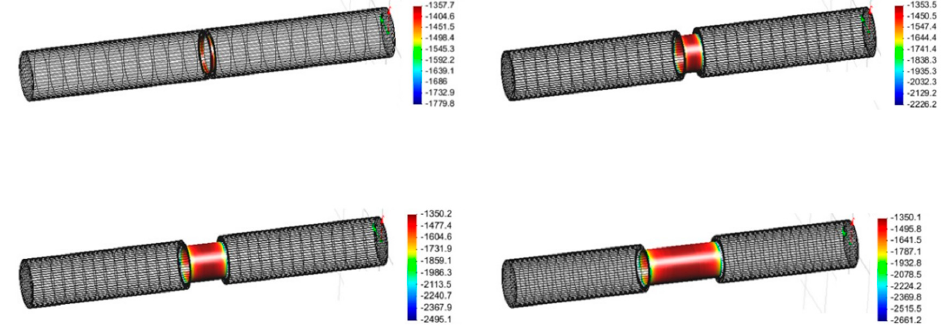
Figure 7. Optimized simulation results (averaged protection potential, mV SCE ) according to the defect